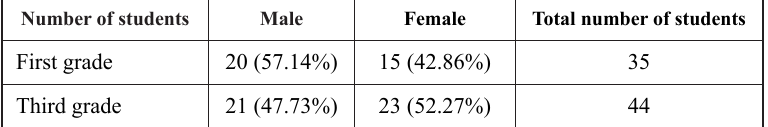
Table 2. Normality of distribution